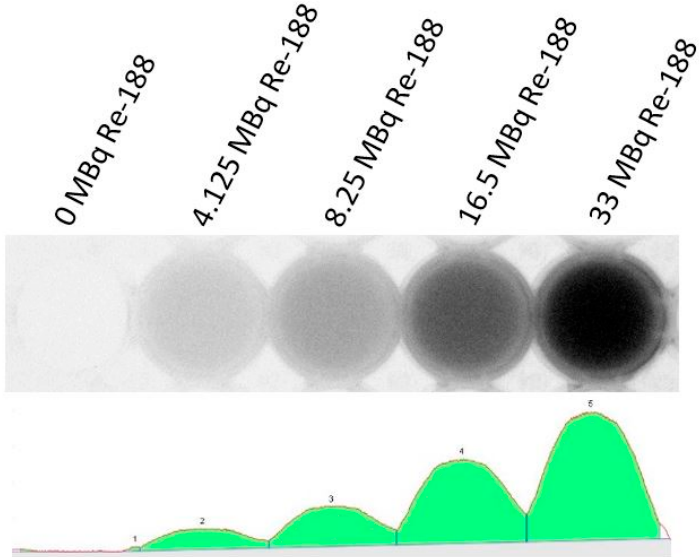
Figure 5. Light intensity of different amounts of Re-188 in a 24-well plate. The picture is inverted, thus, showing increasing intensities of light from left to right (f.l.t.r.: 0, 4.125, 8.25, 16.5, and 33 MBq). The spectrum ( bottom ) was detected by the camera and is shown visually at the top of the figure. If more Re-188 radioactivity is present, the larger the light intensity will be. All intensities were not quantifiable.